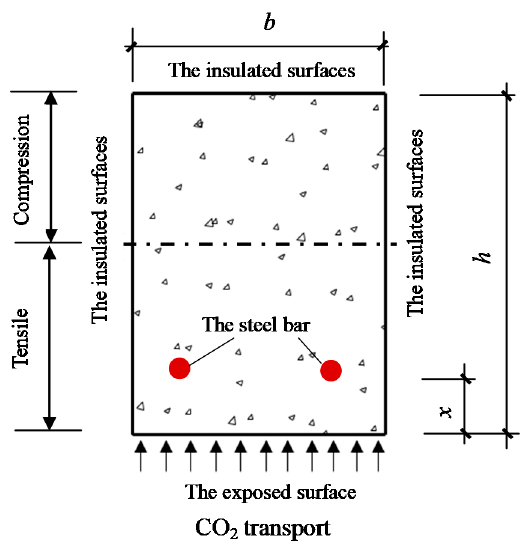
Figure 14. Carbon dioxide transport in the cross section of RC beam.